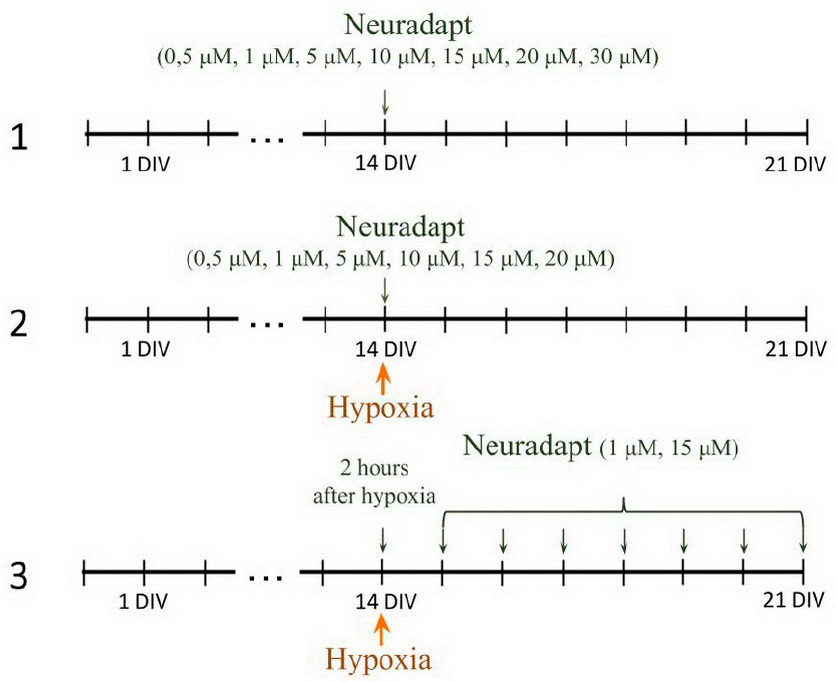
Figure 2. Experimental design flowchart. Step 1, Toxicity evaluation; Step 2, Immediate treatment regime with neuradapt (at the onset of hypoxia); Step 3, Post-treatment regime with neuradapt (2 h post hypoxia, and continues for 7 days).